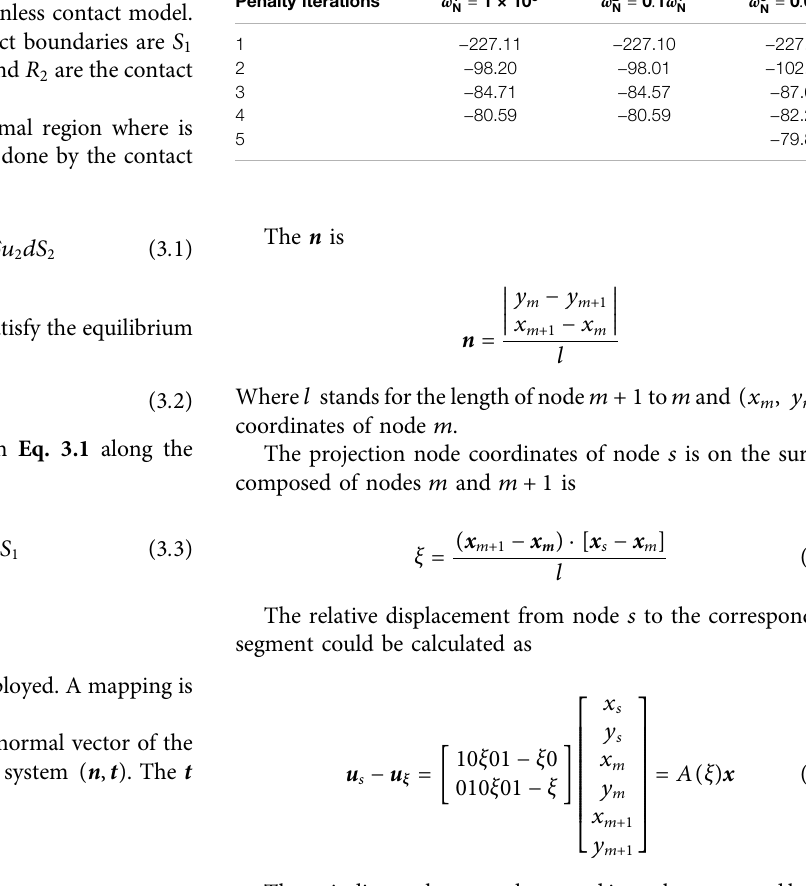
TABLE 1 | The convergence process of penalty function for Hertzian contact. Penalty